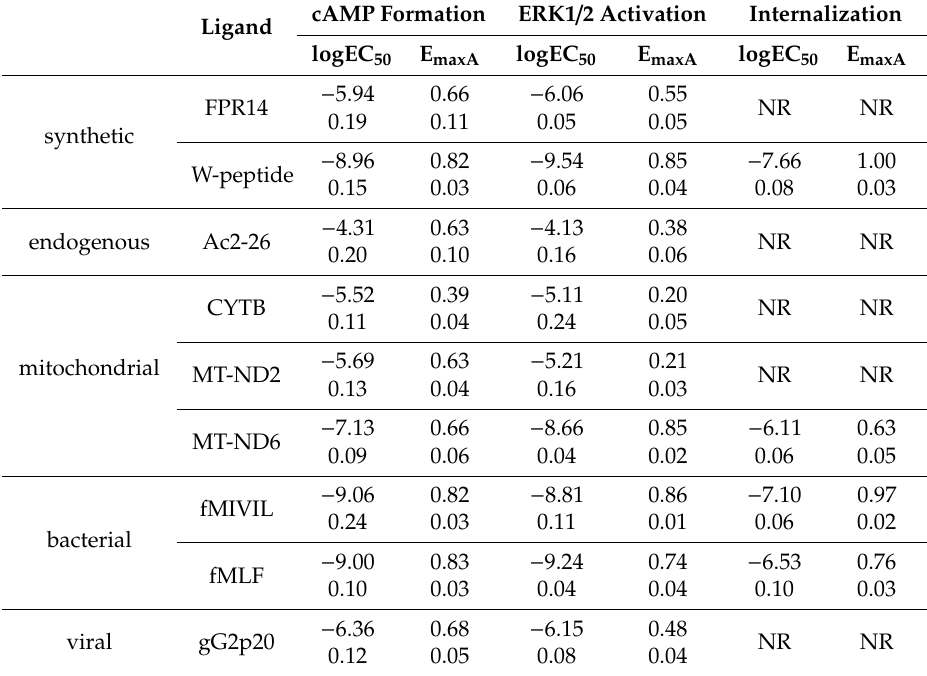
Table A2. Overview of logistic parameters for FPR1 agonists. LogEC 50 and E max were determined for FPR1 ligands for the analyzed pathways. Data are expressed as mean ± SEM values. NR, no